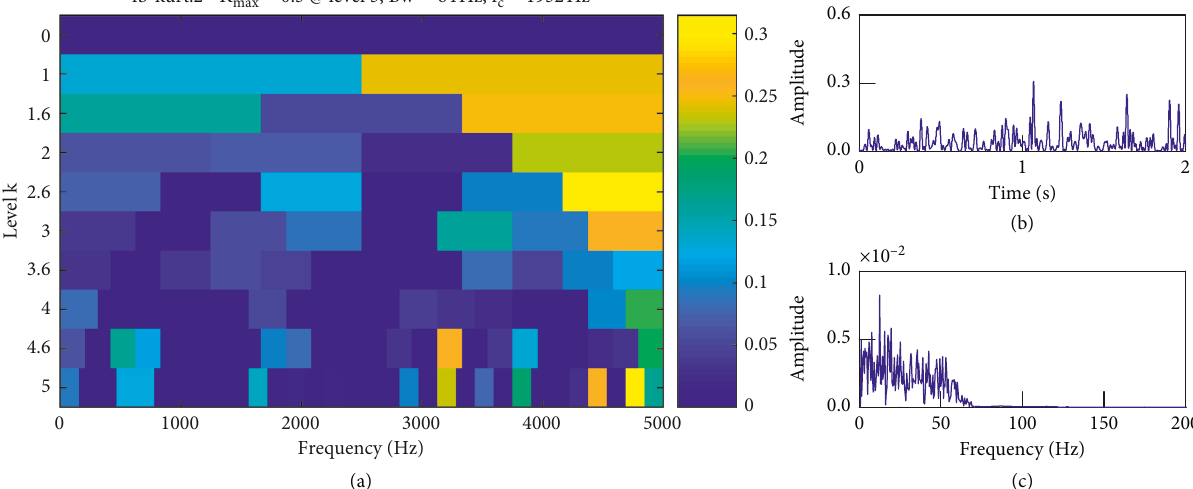
Figure 14: Results obtained by the fast kurtogram: (a) kurtogram; (b) squared envelope of the node with the largest kurtosis value; (c) squared envelope spectrum of